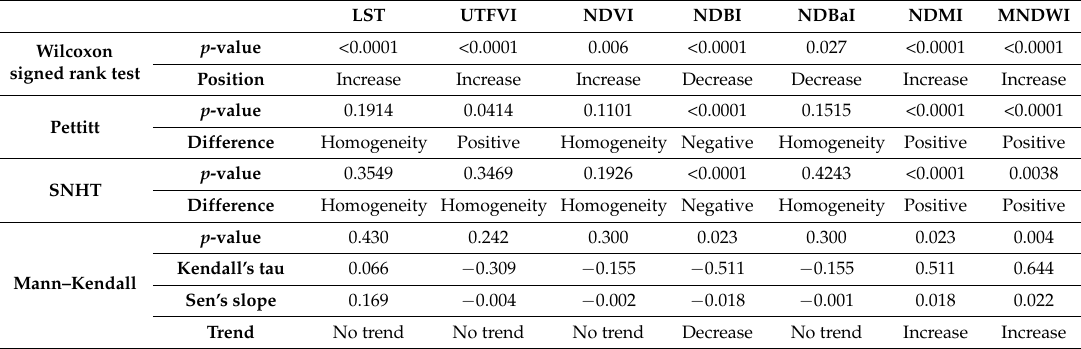
Table 8. Tests results for the Dock site on selected dates for median LST and spectral